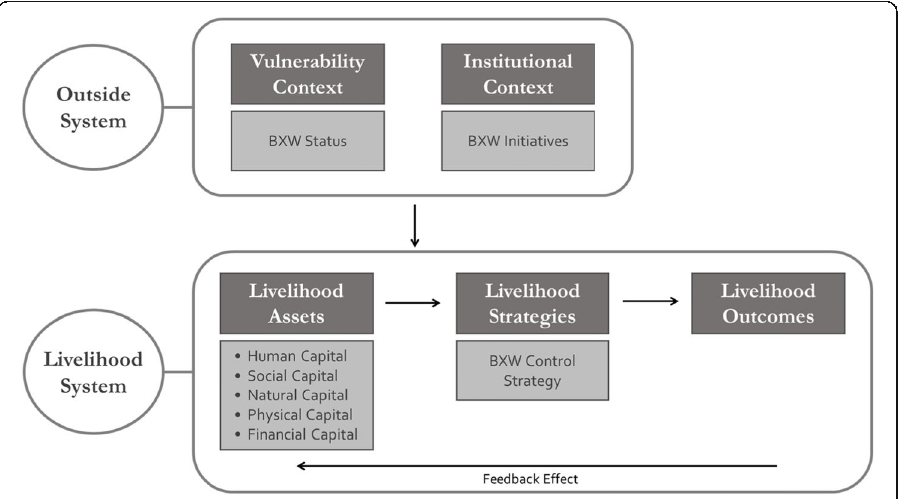
Fig. 1 The Sustainable Rural Livelihood Framework. Source: adapted from Carney et al. (1999) and Scoones